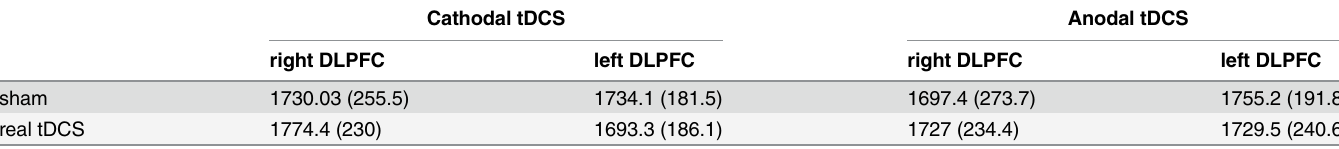
Table 1. Average RTs in the different experimental conditions. Values in parenthesis represent